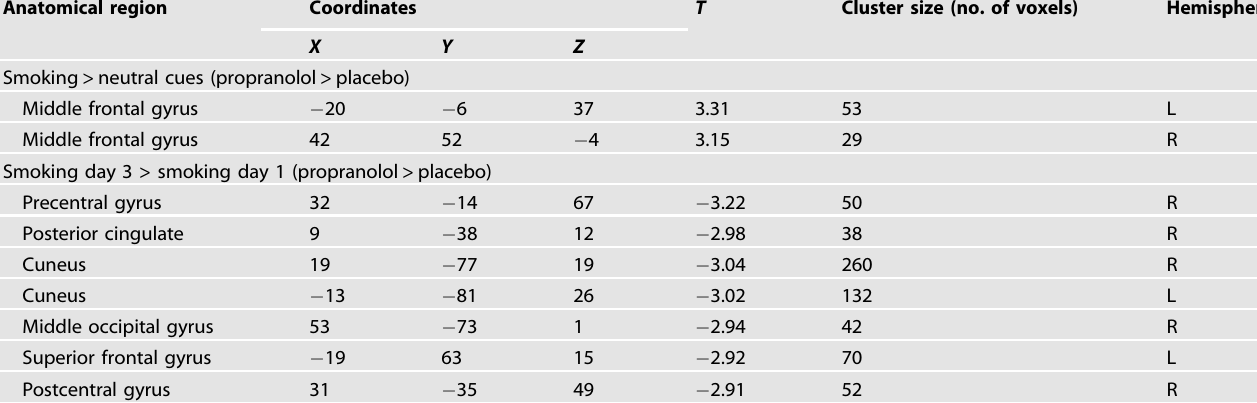
Table 3. Alterations of brain reactivity to smoking-related cues after the reconsolidation manipulation. Anatomical